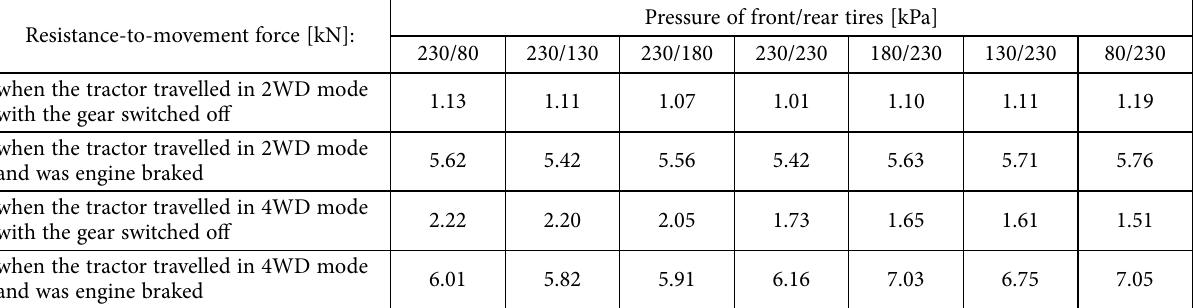
Table 3. Resistance-to-movement force when the tractor travelled for different front and rear tire pressures Resistance-to-movement force